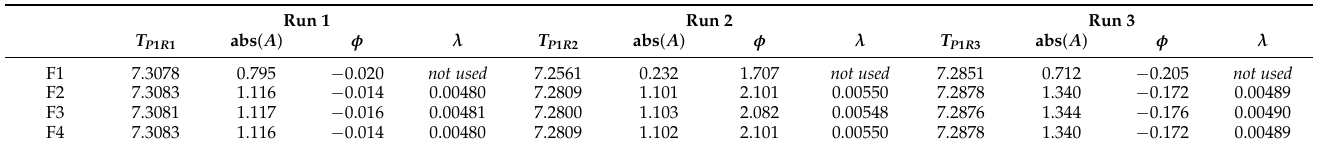
Table 6. Results for the oscillation around P1 for the four different functions to calculate the period T , initial amplitude A , phase angle φ and decay constant λ for three different runs (repeats)—offset for F4 is 0.0004, 0.0012 and − 0.0022 ◦ .